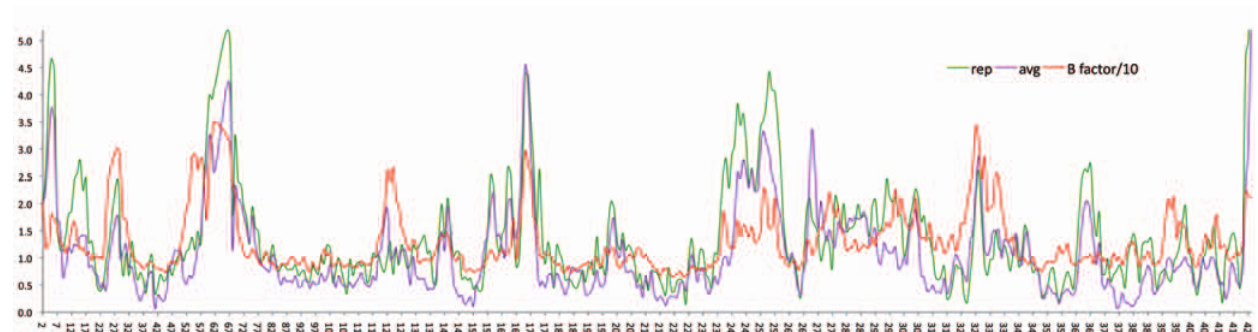
Figure 5. Deviations for alpha carbons between the BoNTAe crystal structure and the aligned MMDS-generated AHP N BoNTAe and B factors for the corresponding alpha carbons of the crystal structure. The crystal structure was taken from Protein Data Bank (Code: 3BON [20]). The representative (rep) and average (avg) conformations of AHP N BoNTAe were obtained from the second-round MMDSs. Horizontal axis: residue ID; vertical axis: alpha-carbon deviation in A˚ and B factors scaled by 10% in A˚ 2